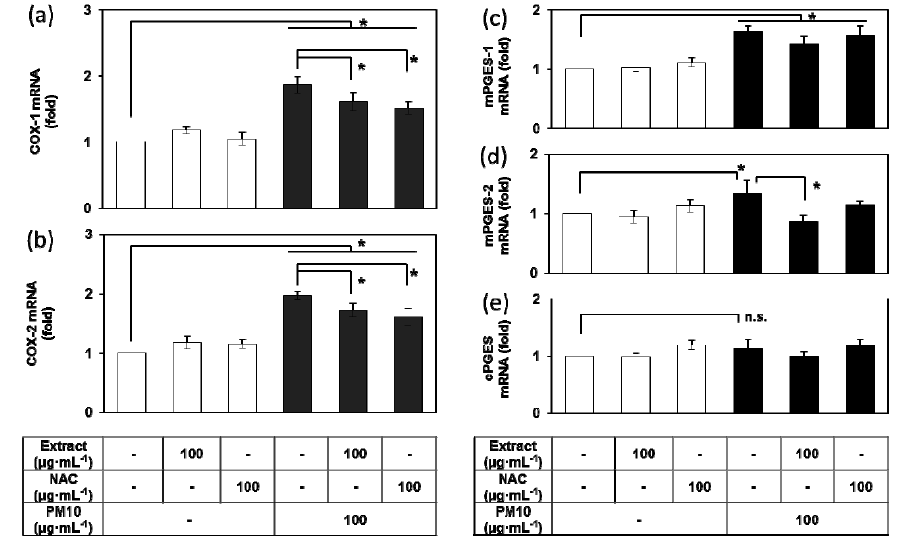
Figure 4. Effects of Ecklonia cava extract on the gene expression of enzymes involved in PGE 2 synthesis in HaCaT keratinocytes exposed to PM10. Cells were treated with PM10 in the presence or absence of E. cava extract or NAC for 24 h for the mRNA assays of cyclooxygenase (COX)-1 ( a ), COX-2 ( b ), microsomal prostaglandin E 2 synthase (mPGES)-1 ( c ), mPGES-2 ( d ), and cytosolic prostaglandin E 2 synthase (cPGES) ( e ). Data are presented as a mean ± SD ( n = 3). All treatments were compared to the PM10 control using one-way ANOVA followed by Dunnett’s test. * p < 0.05; n.s. was not significant.